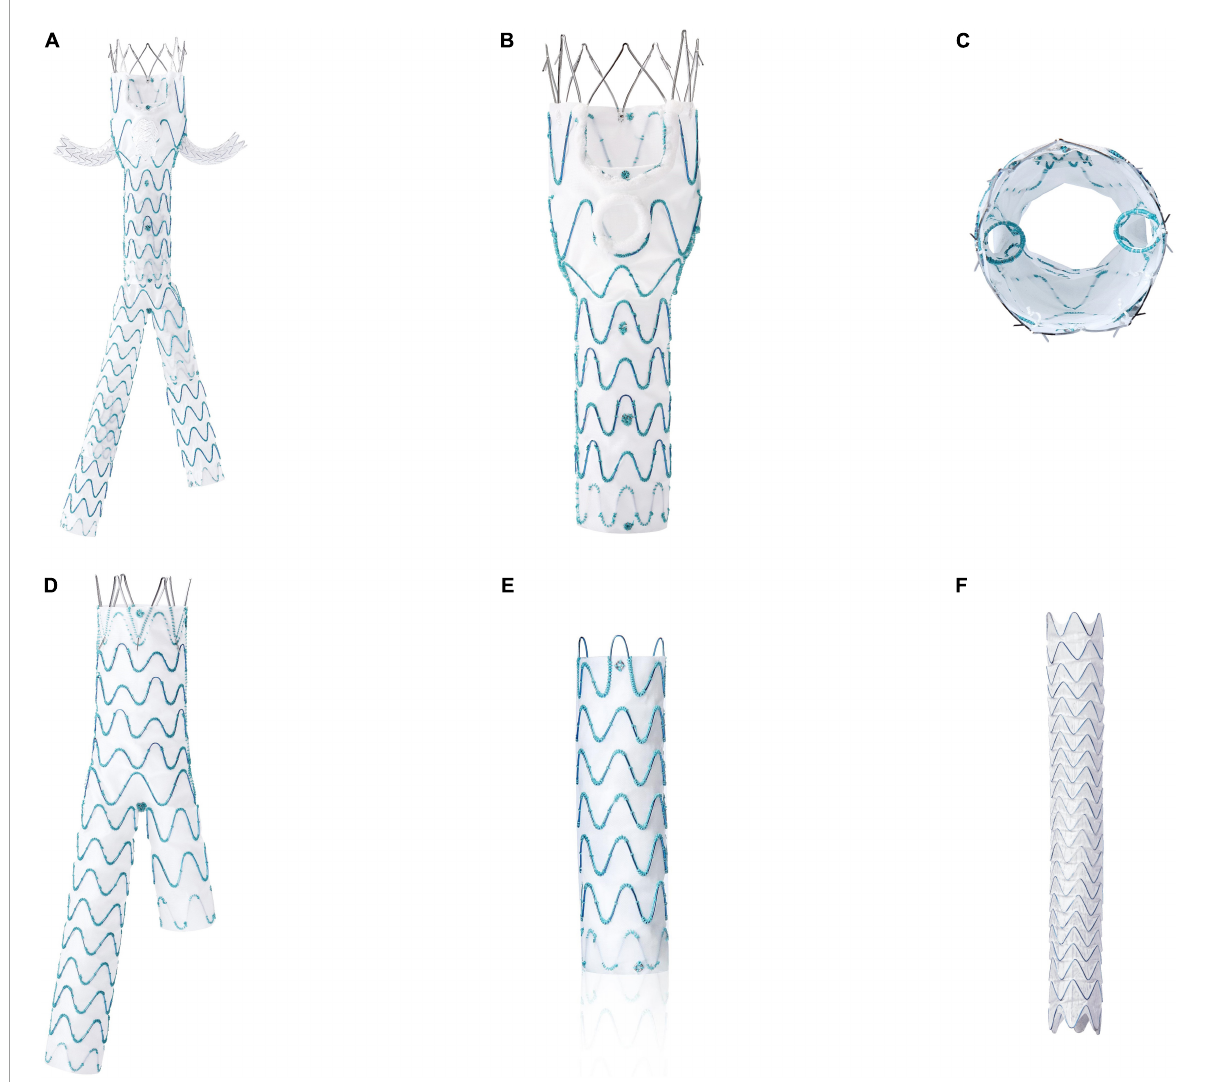
FIGURE1 The WeFlow-JAAA system: a new, off-the-shelf, abdominal aortic stent graft system (A) for JRAAA, comprising a proximal body graft (B,C) , a distal bifurcated body graft (D) , iliac leg grafts (E) and self-expanding branch grafts (F) . The most major characteristic of this device was the design of proximal body graft with two standard inner branches of renal arteries, one 3 mm “mini-inner-cuff” reinforced fenestration for superior mesenteric artery, and one scallop for celiac